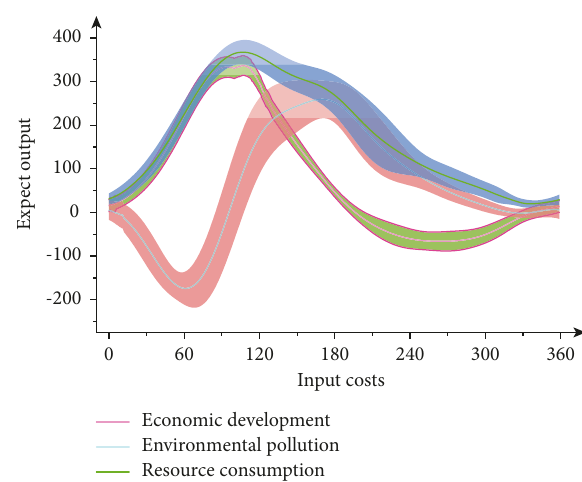
Figure 4: Eco-efficiency evaluation index